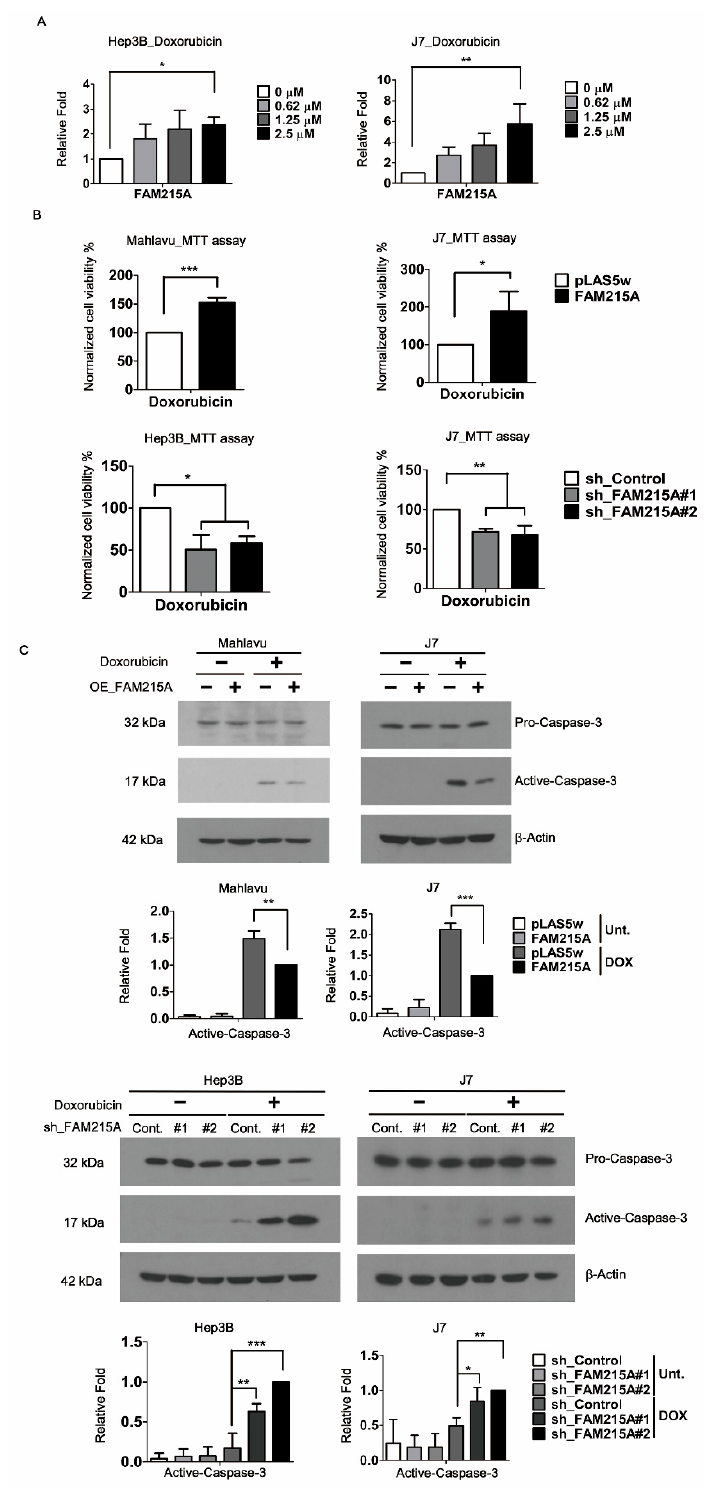
Figure 3. FAM215A is regulated by Doxorubicin and inhibits apoptosis. ( A ) Doxroubicin (0–2.5 µ M) regulates FAM215A expression in Hep3B and J7 cells determined by qRT-PCR. ( B ) Cell viability treated with Doxorubicin with / without FAM215A expression. The data are normalized to the untreated groups. ( C ) Expression of apoptosis marker active caspase-3 and the pro-caspase-3 detected in FAM215A-expressing or knockdown HCC cells treated with Doxroubicin 5 µ M for 24 h by western blot. 18s rRNA and β -Actin was used as the loading controls. Data are presented as means ± SD of three independent experiments (*, p < 0.05; **, p < 0.01; ***, p < 0.001).